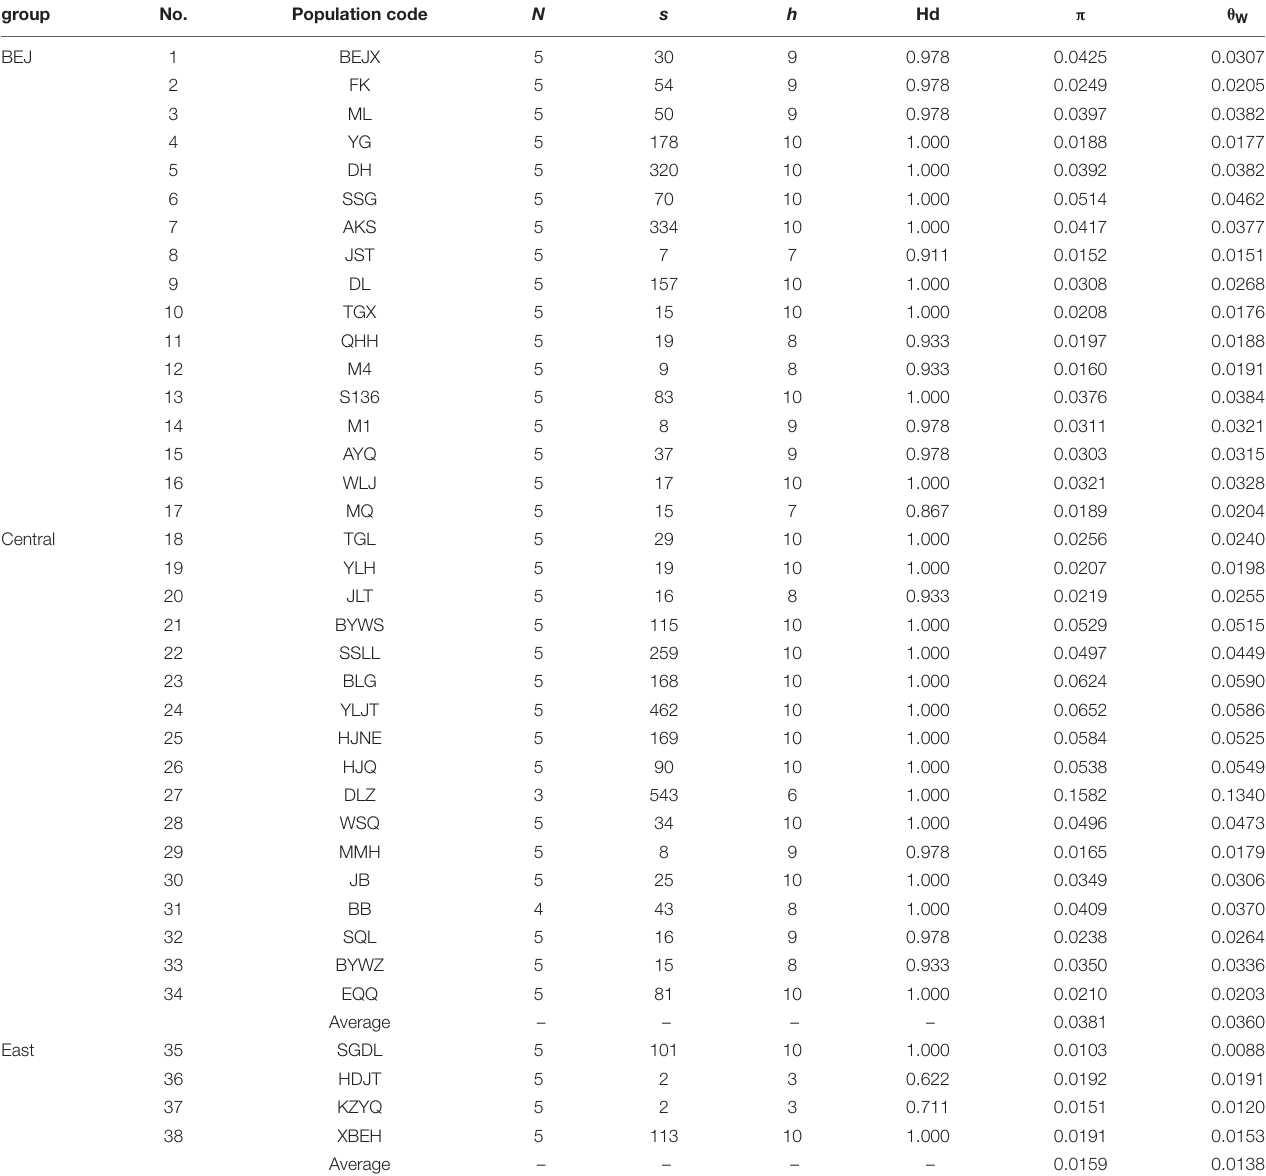
TABLE 1 | Grouping and summary of genetic diversity of each population in A. squarrosum . group